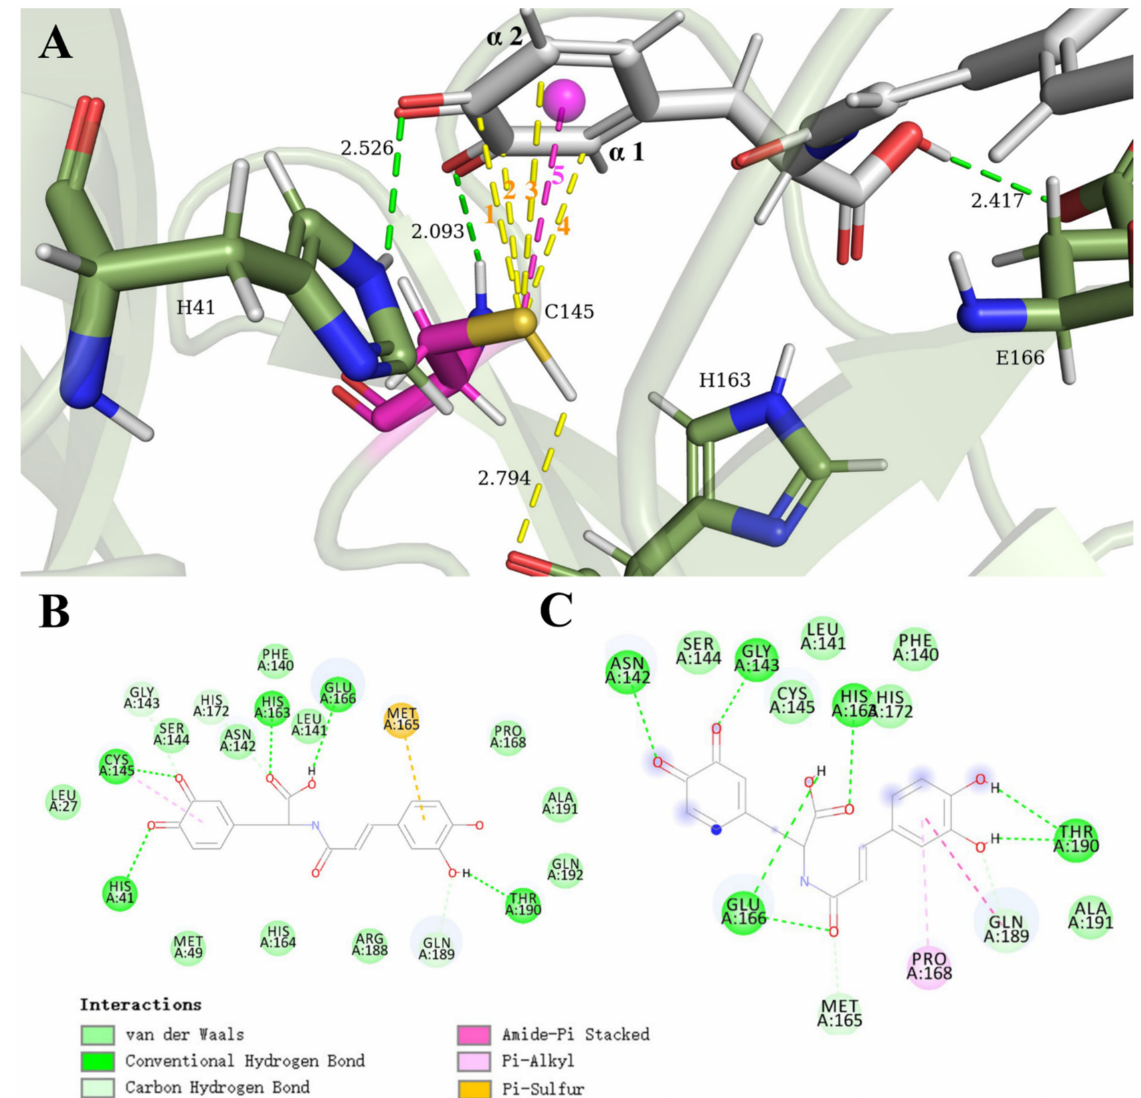
Figure 5. ( A ) Docking pose 1 of clovamide quinone derivative B to M pro . S(C145) points to the ortho-quinone centroid with a close distance of 3.602 Å. The distances between S(C145) and the electrophilic carbons are as follows: 1 : to the C(C=O) para to the R group, 3.552 Å; 2 : to the C(C=O) meta to the R group, 3.168 Å; 3 : to the bottom α carbon ( α 1), 3.508 Å; 4 : to the top α carbon ( α 2), 4.299 Å. Green dash lines indicate hydrogen bonds. ( B , C ) Two-dimensional display of non-covalent interactions between M pro and clovamide quinone derivative B that stabilizes the inhibitor–protease complex. ( B ) Docking pose 1; ( C ) resulting conformation after dynamics